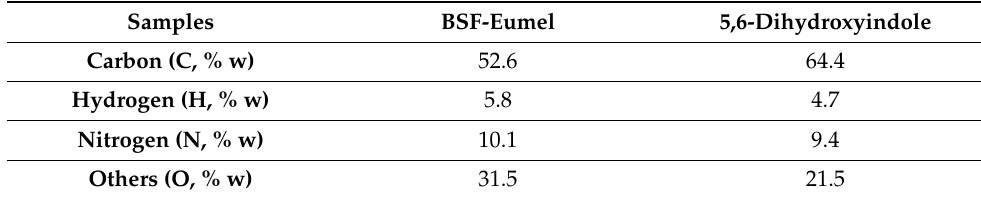
Table 1. Elemental analysis of BSF-Eumel and